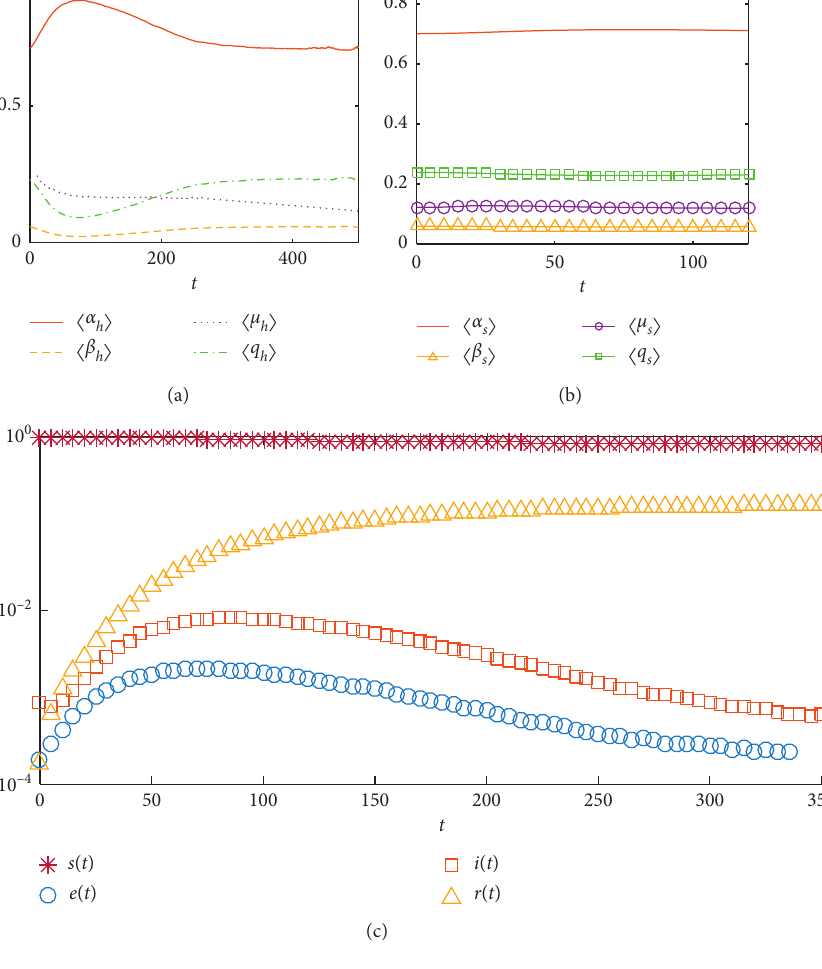
〉 (red line), infection rate 〈 β 〉 (yellow segment), recovery rate 〈 μ 〉 h h h